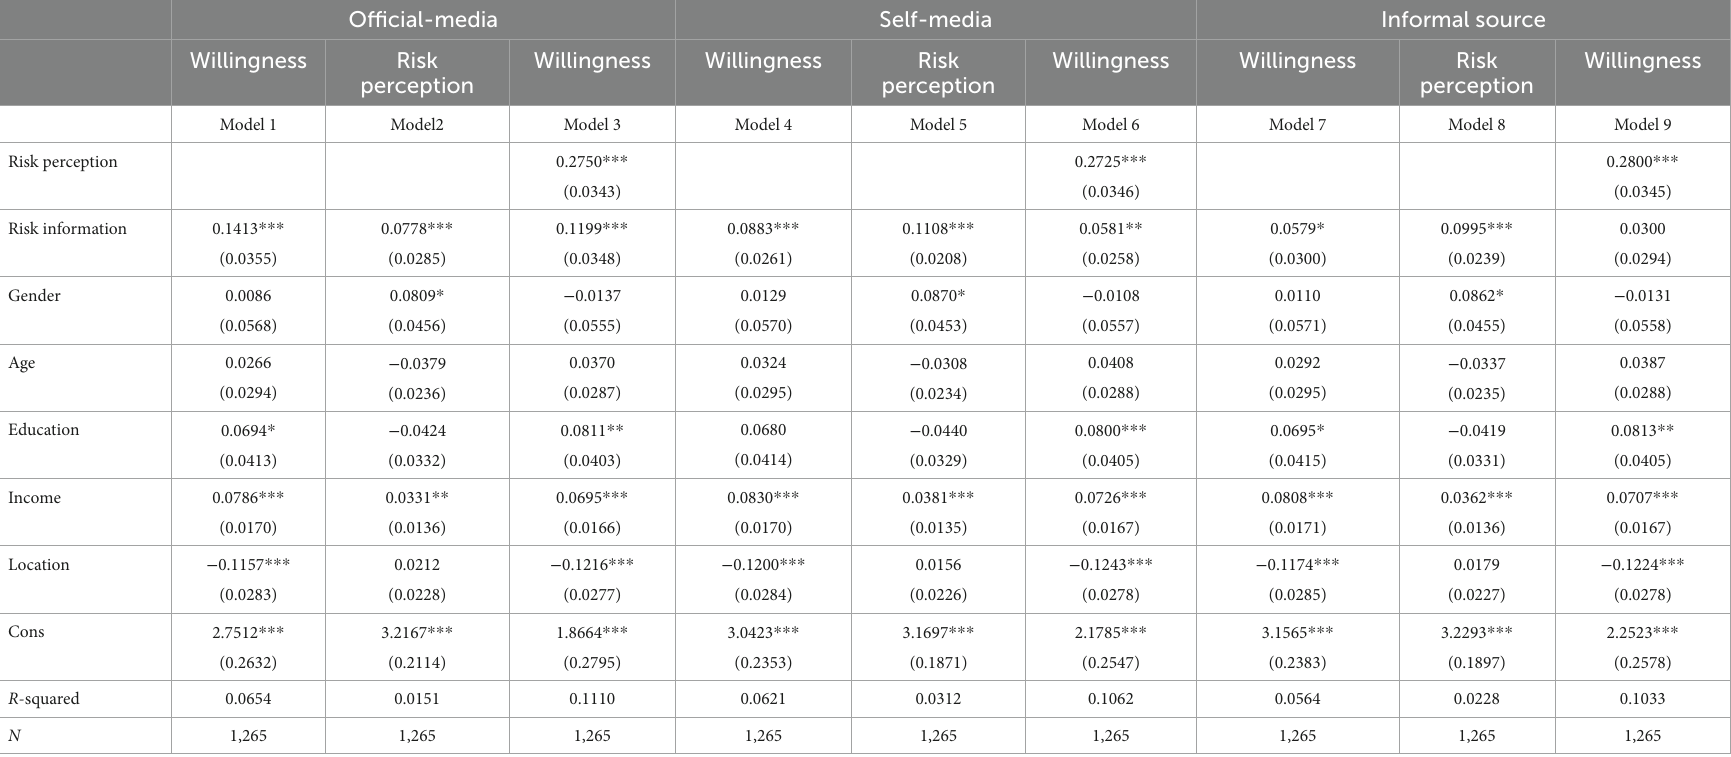
TABLE 3 The formation mechanism of the consumers’ self-protective willingness during the COVID-19